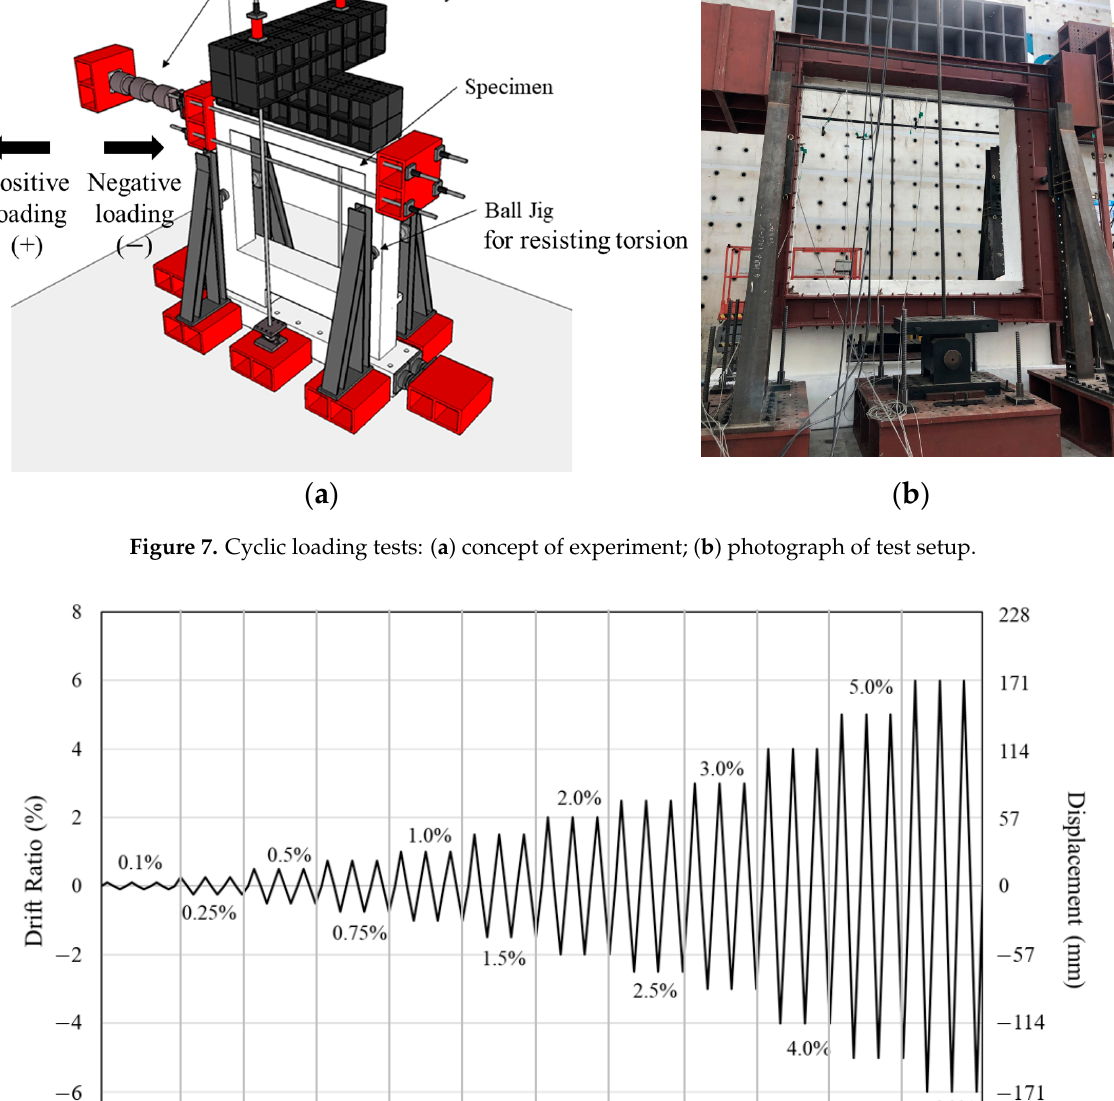
Figure 9. Location of gauges.